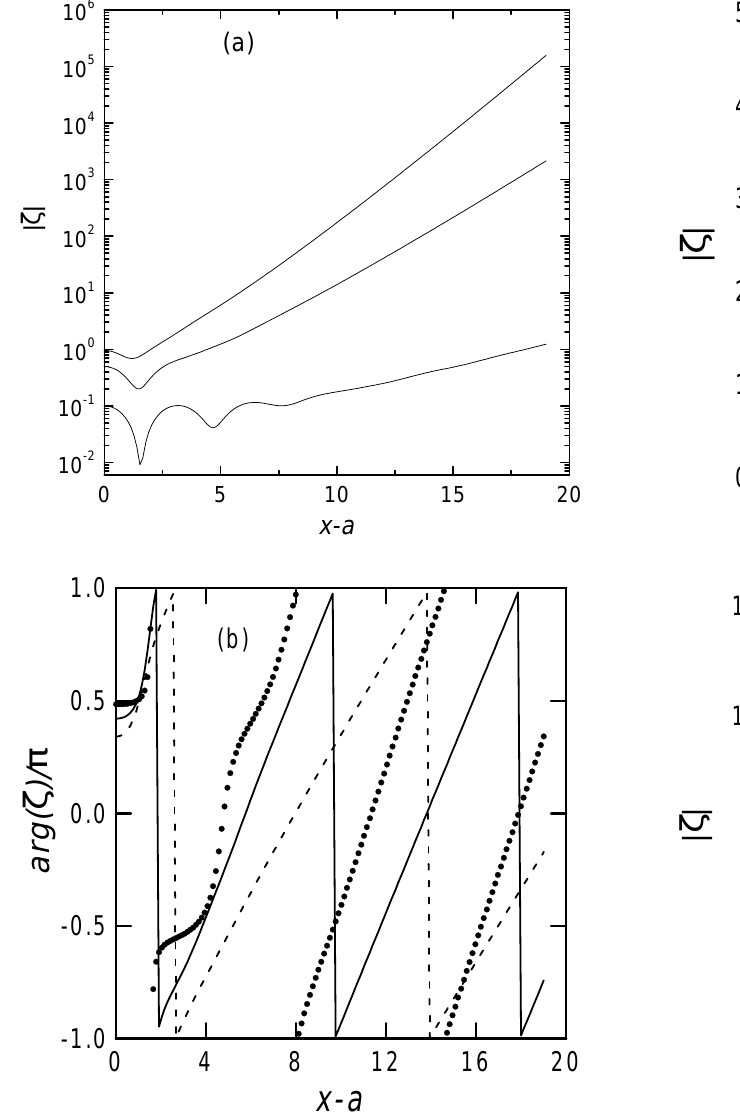
FIG. 3. Dependence of the [dimensionless] amplitude of the coherent signal (solid line) on time ( (cid:116) (cid:173) (cid:67)(cid:115) (cid:121) V ). In both cases, (cid:97) (cid:173) (cid:120) (cid:121) (cid:50) , (a) (cid:120) (cid:173) (cid:50) , (b) (cid:120) (cid:173) (cid:54) . The dashed line and solid dots on these pictures show the contributions from z (cid:97) and z (cid:119) ,